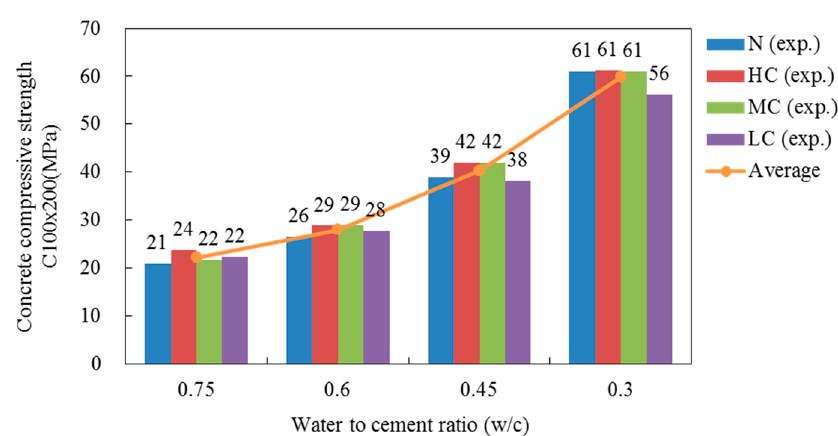
Figure 7. Compressive strengths under different water-to-cement ratios.